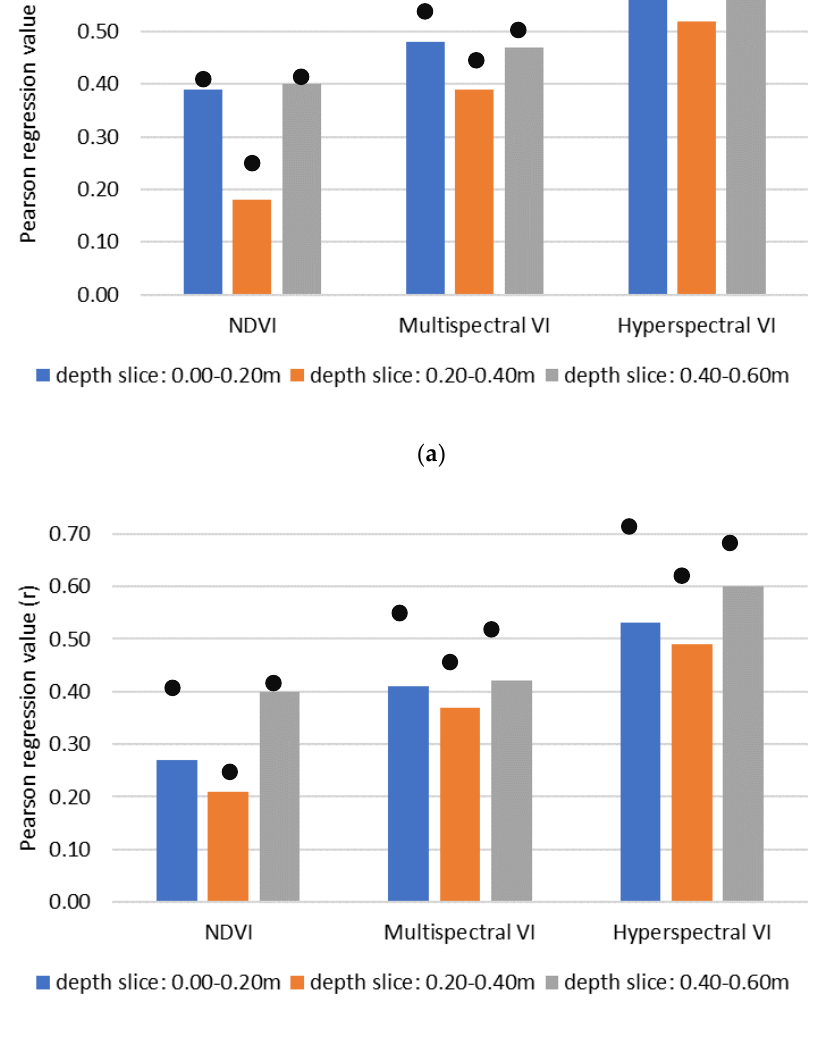
Figure 9. Pearson regression value ( r ) of fusion between the ( a ) noisy GPR depth slices of level 0.1 and ( b ) noisy GPR depth slices level 0.2 for a depth slice of 0.00–0.20 (blue color), 0.20–0.40 (orange color) and 0.40–0.60 m (gray color). The regression model was tested between the noisy GPR depth slices against the (i) NDVI, (ii) 13 multispectral vegetation indices and (iii) 53 hyperspectral vegetation indices (see details for multispectral and hyperspectral indices in Tables A1 and A2 respectivelly, Appendix A). Correlation achieved with the noiseless dataset is shown with a dot for each depth slice.